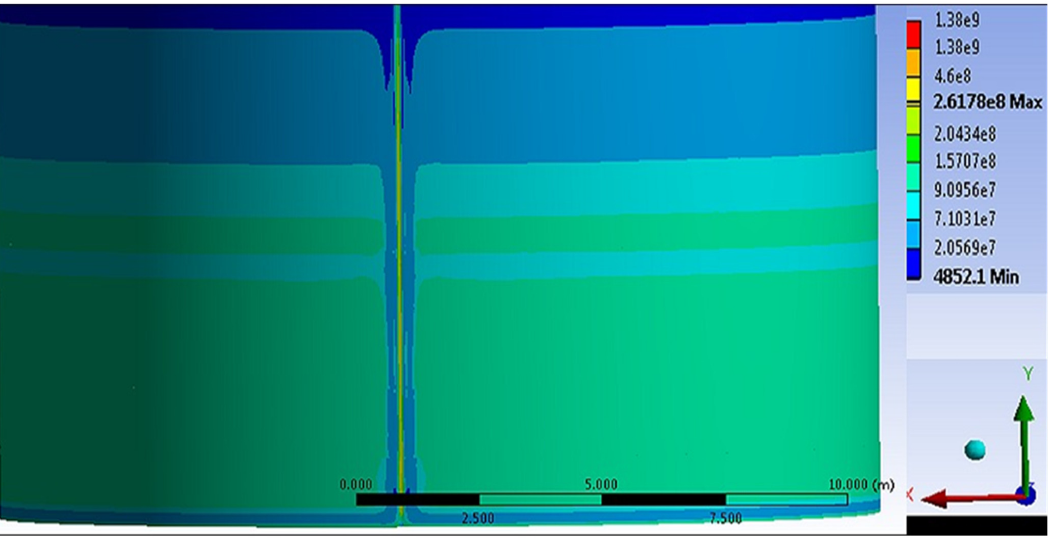
Figure 16. Distribution of equivalent stresses in the field joint zone with the joint imperfection at a = 50 cm; f = 15 cm.